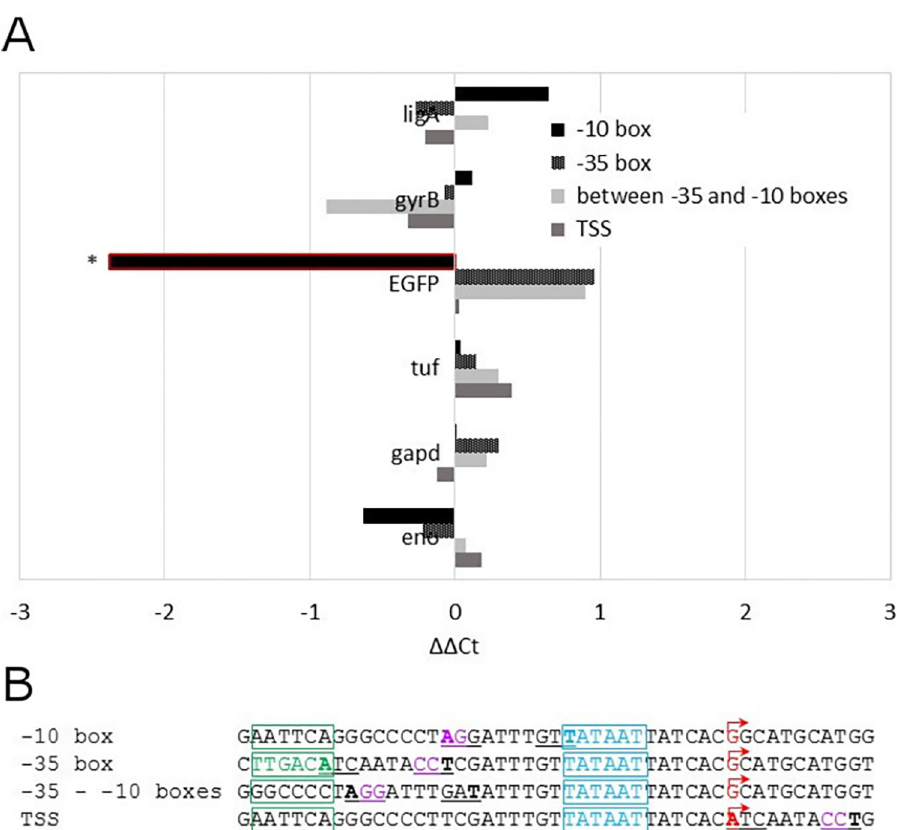
Fig 8. A–Difference between the expression levels of paired genes for mutants with EGFP genes under synthetic promoters, with or without methylation sites. For each pair, the difference for EGFP gene in comparison with control genes eno , gadp , tuf , ligA , and gyrB is shown. Genes with significant difference between promoters with or without the methylation site (Student’s t -test, Benjamini–Hochberg correction, P < 0.05) are shown with red boxes and asterisks. B–Sequences of paired EGFP promoters with or without methylated sites in -10 box, -35 box, between -35 and -10 boxes, and in the TSS. Methylation sites are underlined; methylated adenines in forward and reverse strands are in bold; -10 boxes are in blue and highlighted with blue boxes; -35 boxes are highlighted with green boxes and the sequence with strong consensus to the -35 box is in green; TSSs are in red and marked with red arrows; sequence differences between paired methylated or non-methylated promoters are in